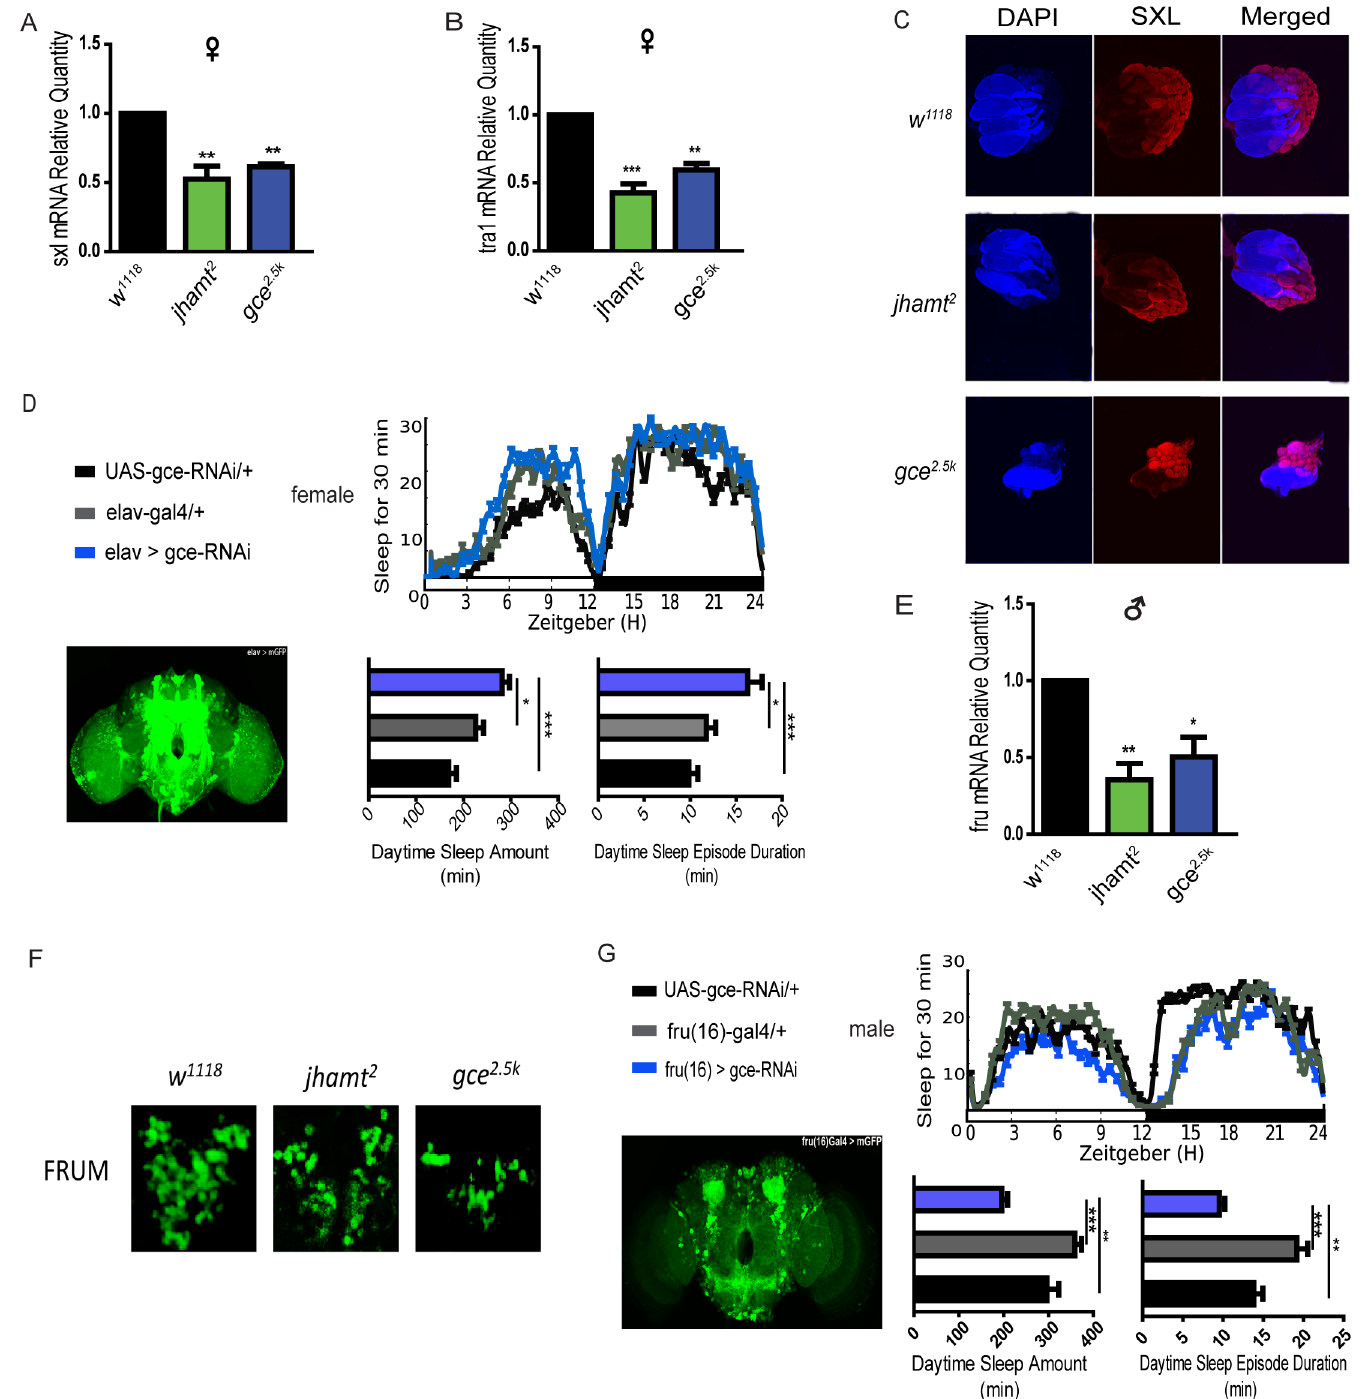
Fig 4. JH-GCE signaling pathway affected sex-related gene expression. (A, B and E) Sxl , tra1 and fru relative transcription levels in w 1118 , jhamt 2 and gce 2 . 5k female or male flies. Data represent mean±SEM. (cid:3) P < 0.05, (cid:3)(cid:3) P < 0.01, (cid:3)(cid:3)(cid:3) P < 0.001 determined by Student’s t test. (C) The protein expression of SXL in female ovary. First row: w 1118 ; Second row: jhamt 2 ; Third row: gce 2 . 5k . The blue represents DAPI, the red represents anti-SXL, and the third column represents co-location of DAPI and anti- SXL. (D) Sleep analysis of female flies with gce dsRNA interference driven by elav-gal4 . The color of dark, gray and blue represent UAS-gce-RNAi , elav-gal4 (as controls) and elav > gce-RNAi , respectively. The line diagram is sleep trace graph; the two histograms are daytime sleep amount and daytime sleep-bout duration quantification. The bottom left figure shows the neurons with gce dsRNA interference, as detected with a GFP reporter. (F) FRU M protein expression in pars intercerebralis of w 1118 , jhamt 2 and gce 2 . 5k . (G) Sleep status of male flies with gce dsRNA interference in fru(16)-gal4 neurons. The color of dark, gray and blue represent UAS-gce-RNAi, fru (16)-gal4 and fru(16) > gce-RNAi, respectively. The line diagram is sleep trace graph; the two histograms are quantified analysis of the sleep amount and sleep bout duration during daytime. The bottom left figure shows the neurons with gce dsRNA interference, as detected with a GFP reporter. https://doi.org/10.1371/journal.pgen.1007318.g004 PLOS Genetics | https://doi.org/10.1371/journal.pgen.1007318 April 4,